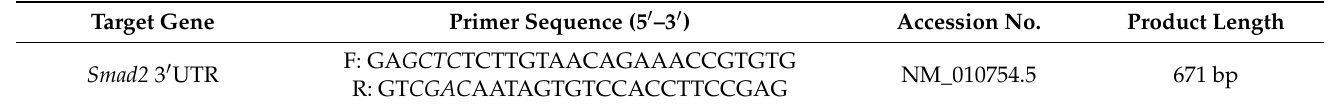
Table 2. Primer sequences of the Smad2 3 (cid:48) untranslated region (UTR). Target Gene Primer Sequence (5 (cid:48) –3 (cid:48) ) Accession No. Product Length